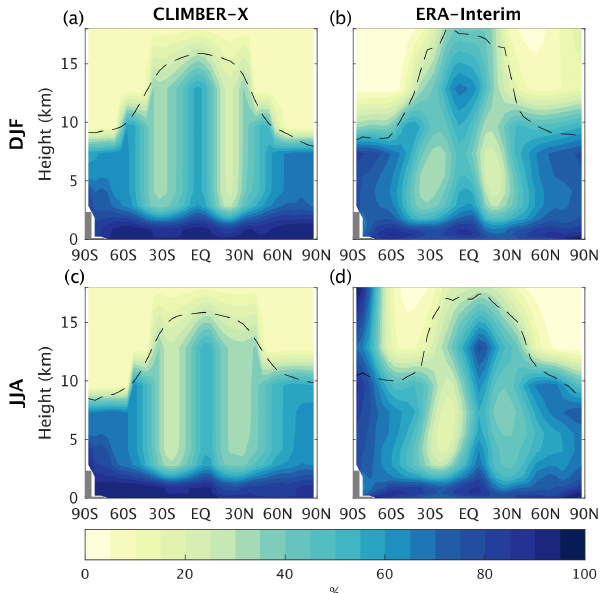
Figure 8. Zonal mean relative humidity simulated by CLIMBER-X for (a) DJF and (c) JJA compared to ERA-Interim reanalysis (Dee et al., 2011) (b, d) . The dashed black line indicates the height of the tropopause.